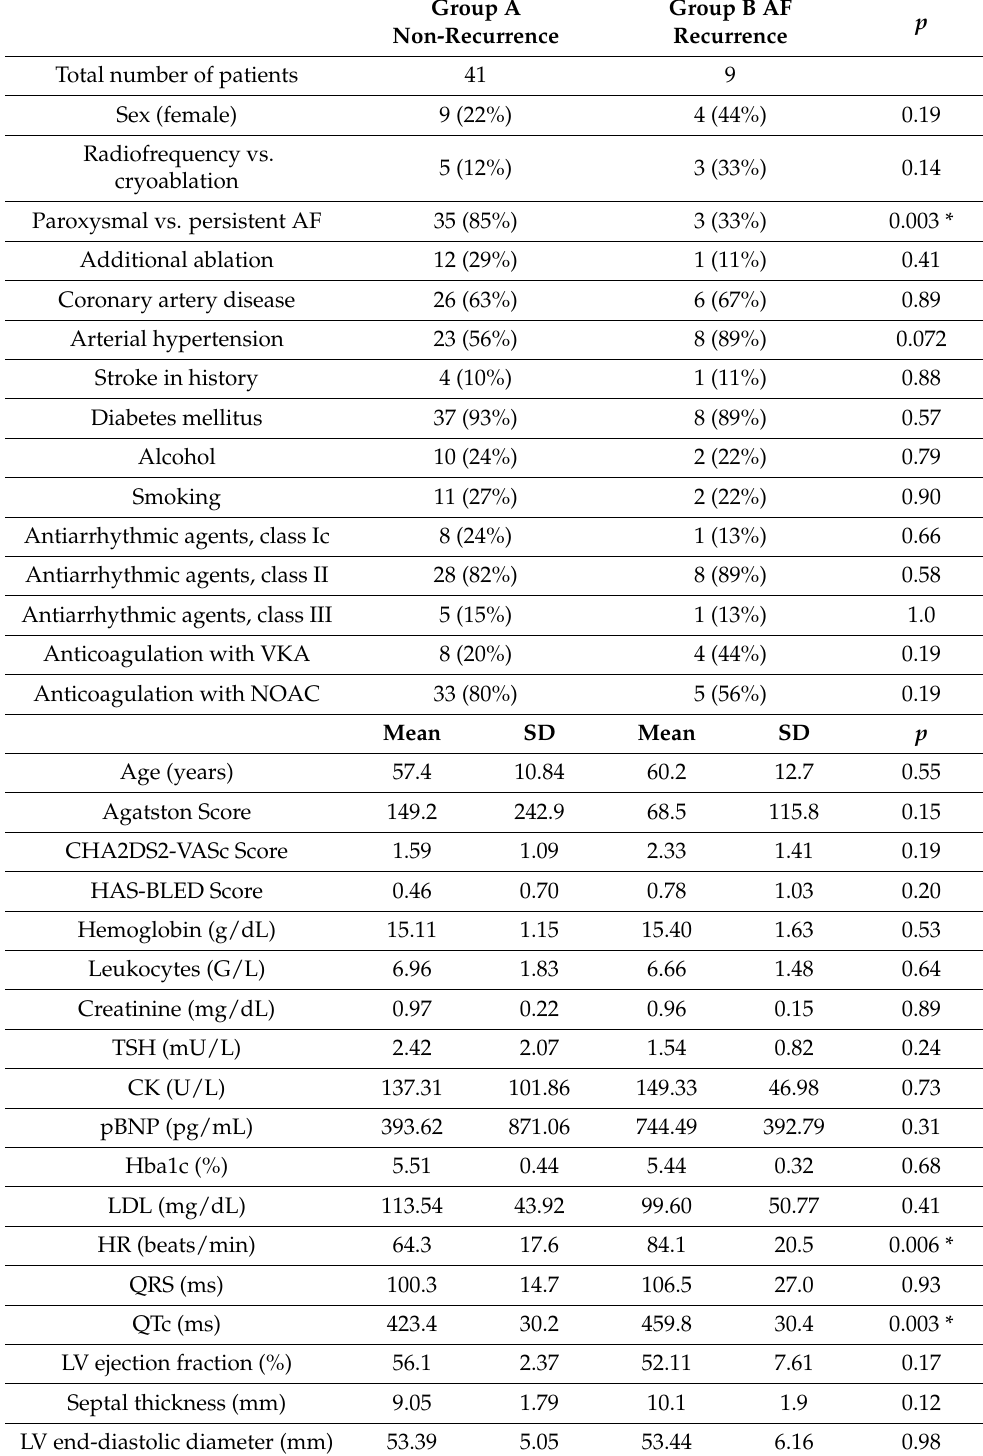
Table 1. Comparison of demographic and clinical baseline characteristics for both groups (group A: sinus rhythm; group B: atrial fibrillation (AF)